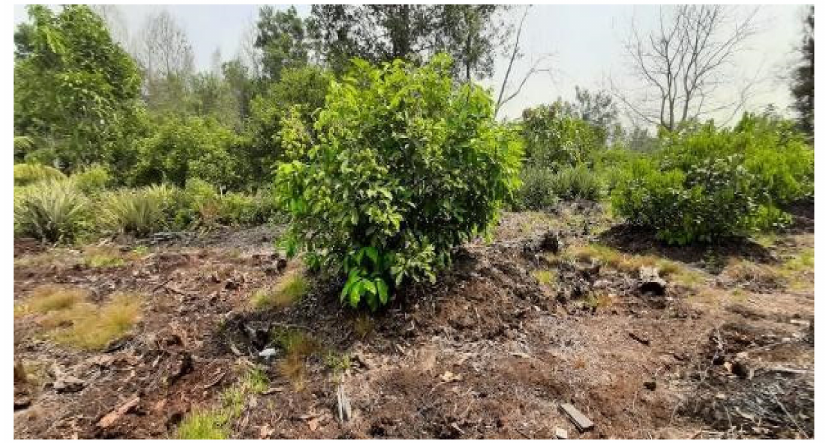
Figure 8. Example of fruit tree growing on a peat